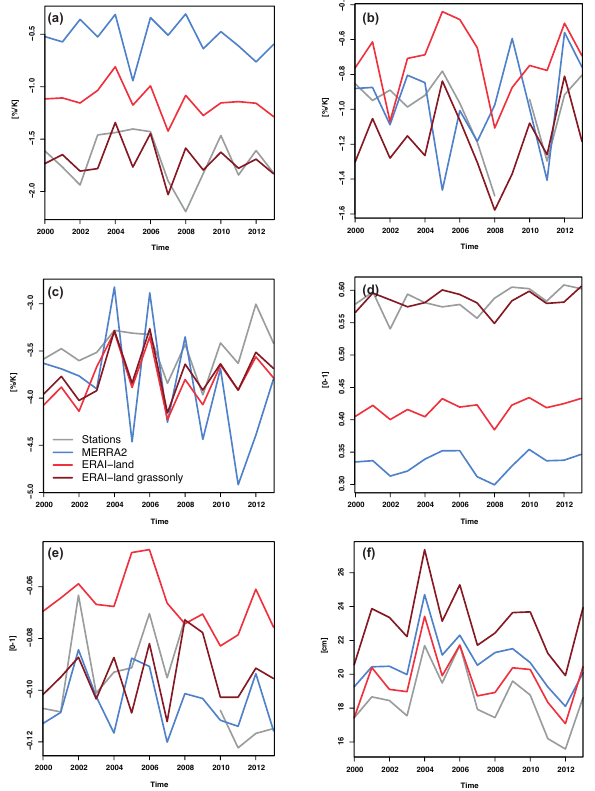
Figure 6. Yearly time series of selected MAMJ SAF components averaged over all 44 locations: (a) SNC, (b) TEM, (c) snowmelt sensitivity, (d) snow albedo, (e) snow albedo change within the sea- son, (f) snow depth.